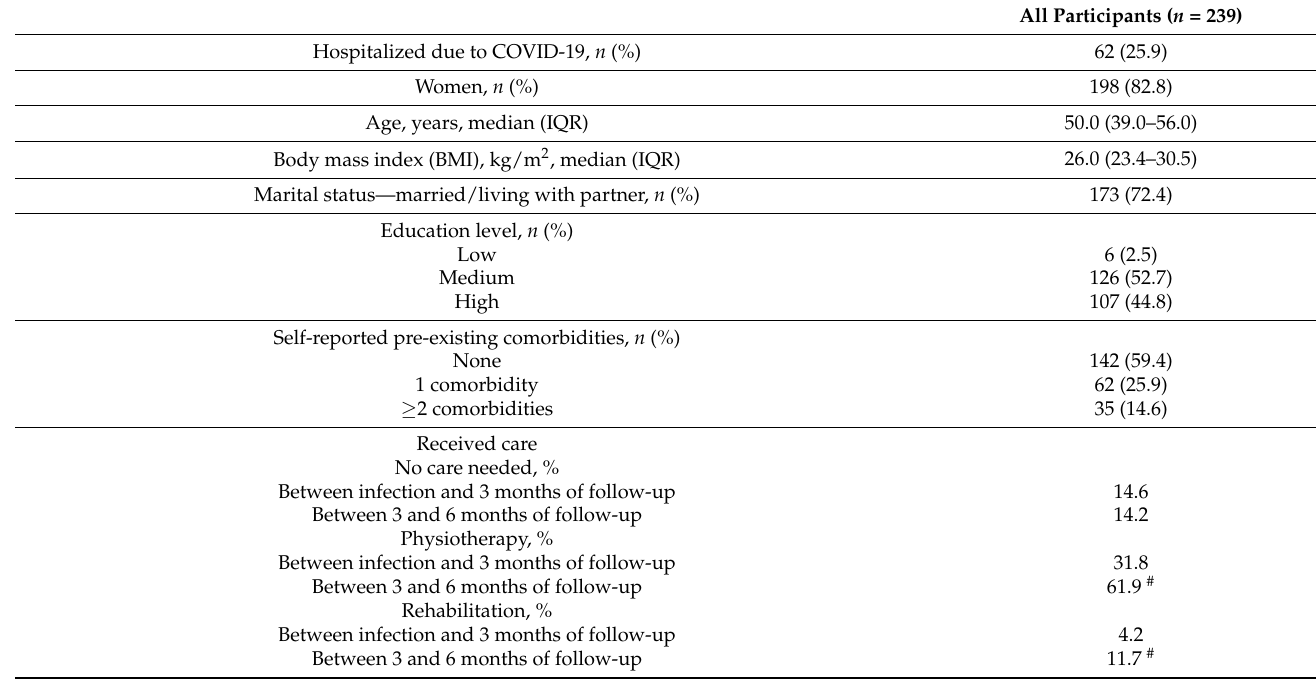
Table 1. General characteristics of